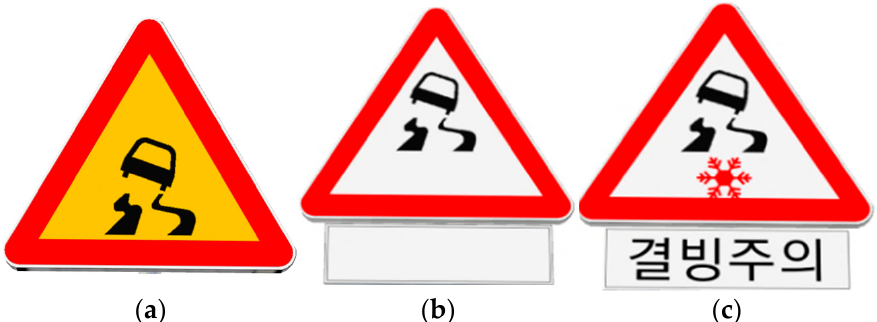
Figure 3. The signs used for VR simulator experiments: ( a ) conventional static warning sign for black ice; ( b ) new warning sign not actuated by weather conditions; ( c ) new warning sign actuated by weather conditions. The Korean sign means “Caution on Black Ice”.